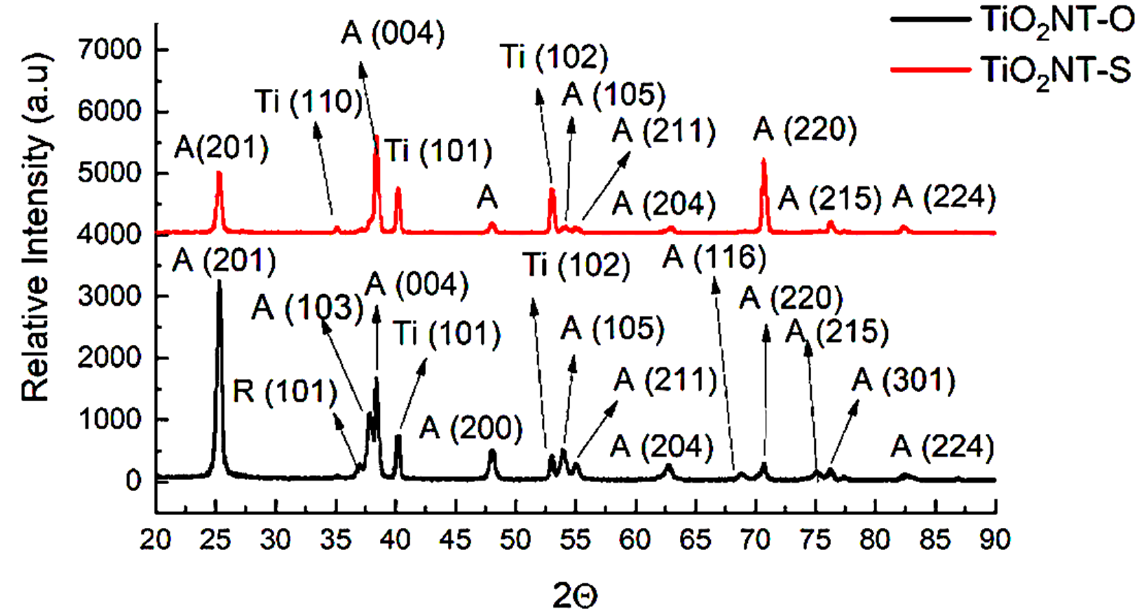
Figure 4. X-ray diffraction patters taken from the anodized surfaces. A = anatase, R = Rutile, Ti = Titanium. The peak at 25 ◦ corresponding to the TiO 2 NT-S plot is less intense that the counterpart pertaining to the TiO 2 NT-O. This contains peaks from different planes of anatase, namely, (103) and (004) which are manifested in a bifurcated peak at around 38 ◦ . The